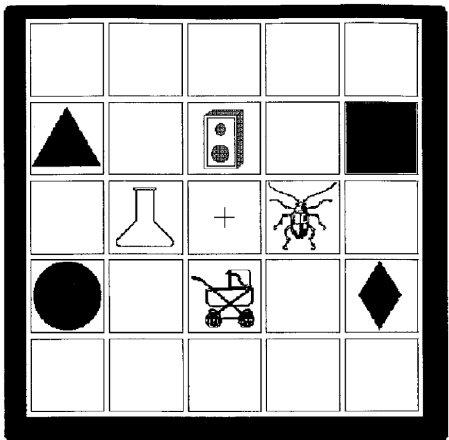
Figure 3. Example of a typical display in task- or action-based studies taken reprinted with permission from [18]. Copyright 1998 Elsevier. Participants were asked to, e.g., Pick up the beaker and put it above the triangle .